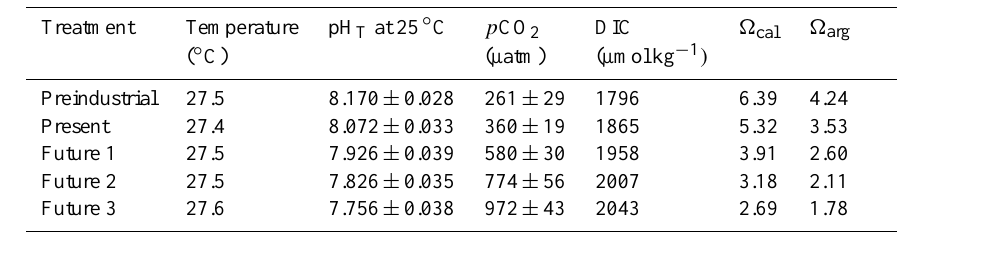
Table 1. Mean physical and chemical conditions in each p CO 2 treatment. Standard deviations are shown for pH T and p CO 2 . The mean salinity and total alkalinity, which were measured repeatedly during the experiments, were 34.4 and 2188µmolkg − 1 , respectively. The value of DIC (dissolved inorganic carbon), (cid:127) cal and (cid:127) arg (saturation state of seawater with respect to calcite and aragonite) was calculated from the total alkalinity and p CO 2 .